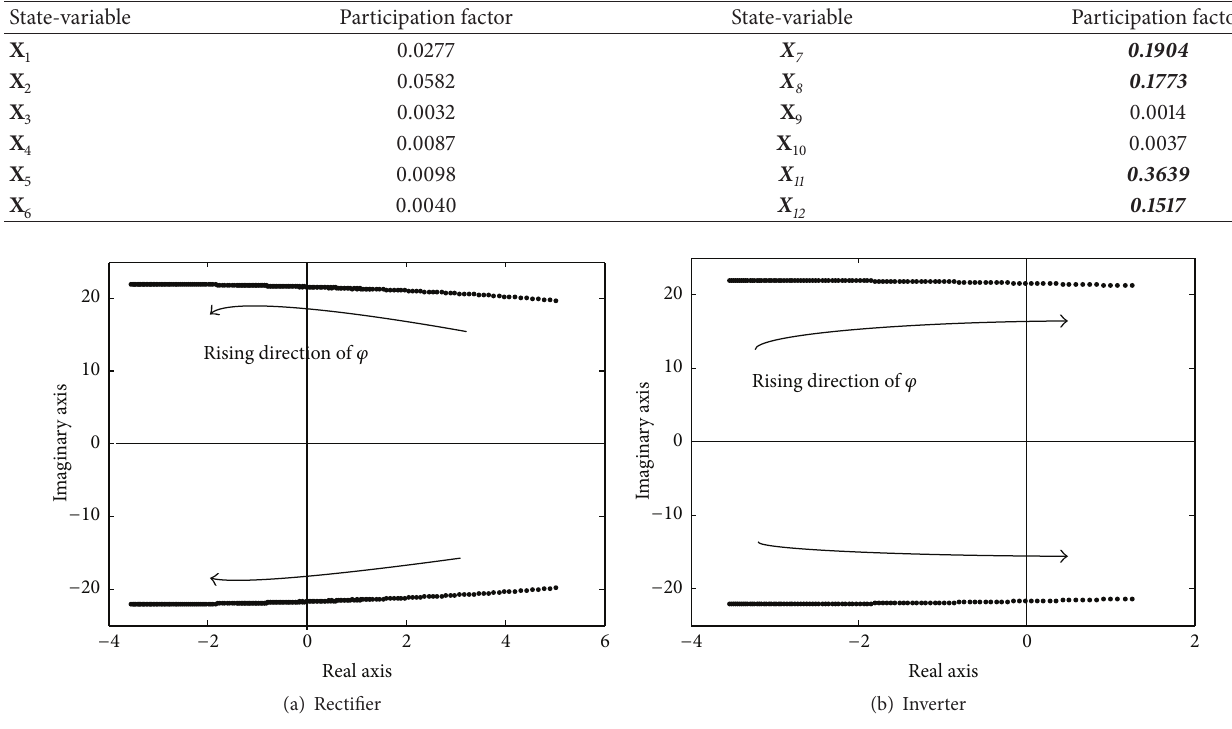
Figure 5: Root-locus of predominant poles with 𝜑 change.